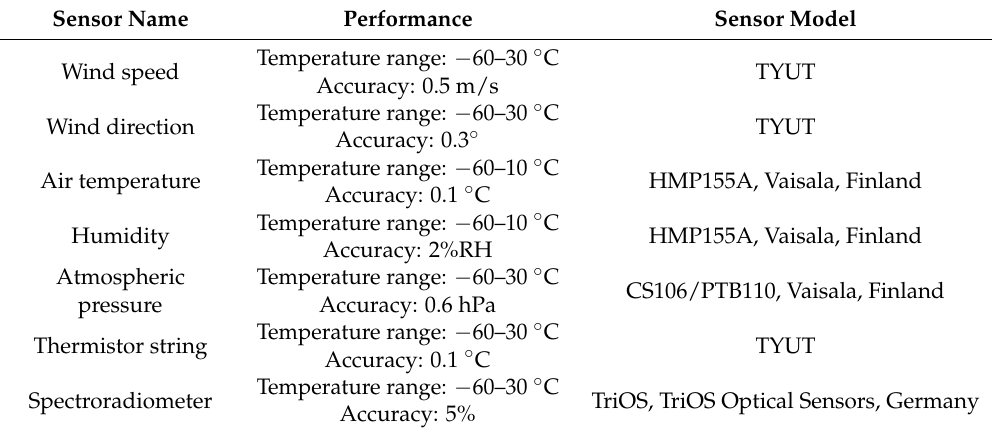
Table 1. Sensor information of the observing